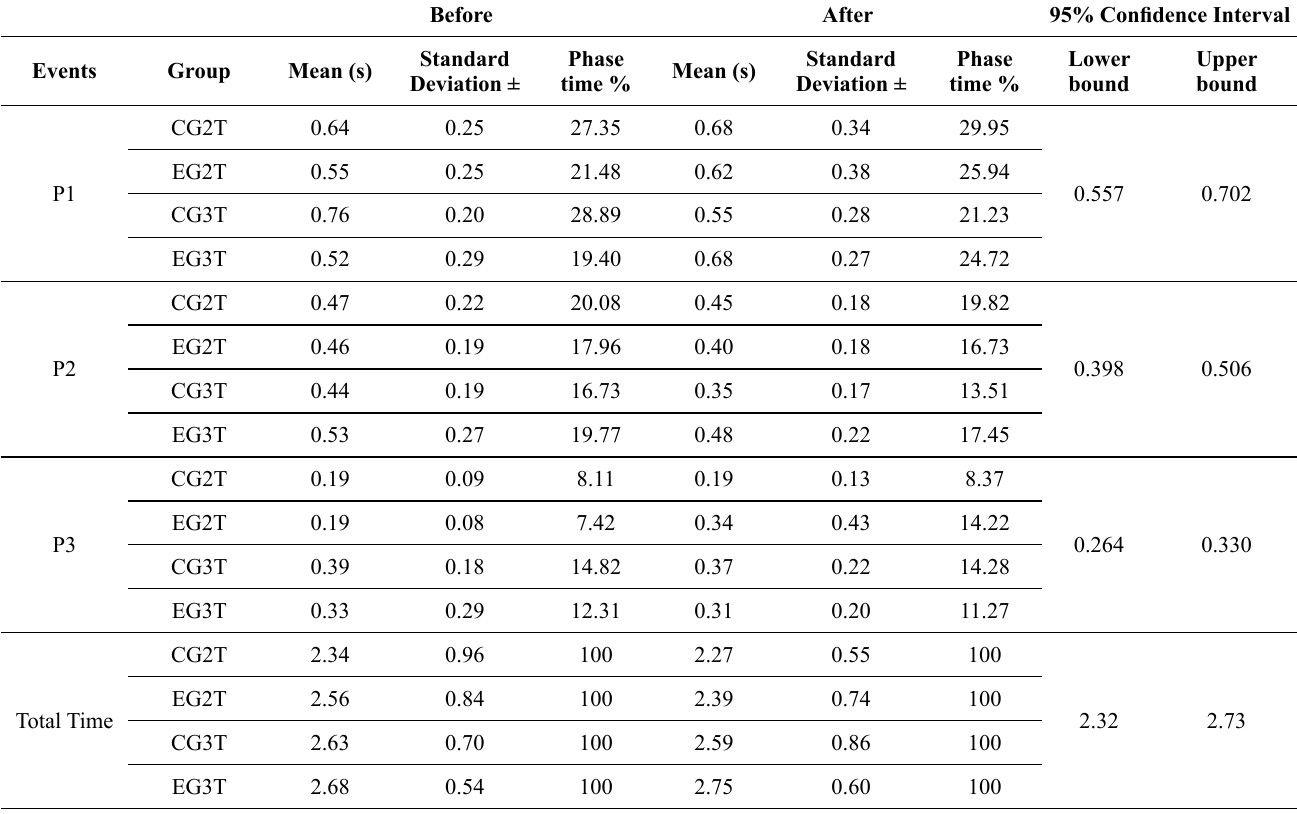
Table 3. Comparison of the phase duration and the total time of the movement in seconds considering the two evaluation moments between the analyzed groups Events Group Mean (s)